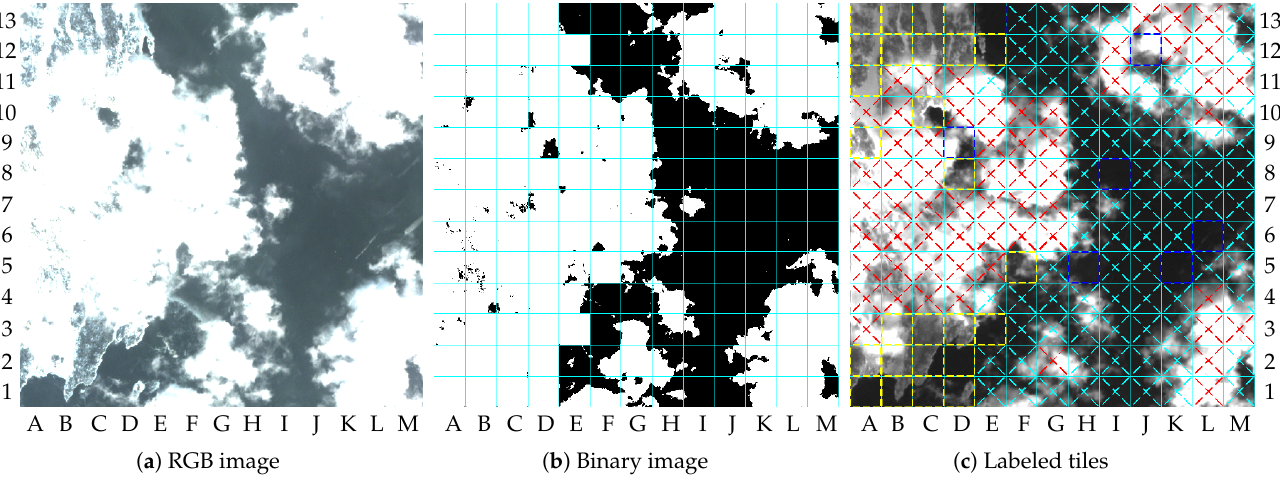
Figure 17. Results for image 21: ( a ) RGB image (truncated at 2000); ( b ) binary image; ( c ) labeled tiles (truncated at